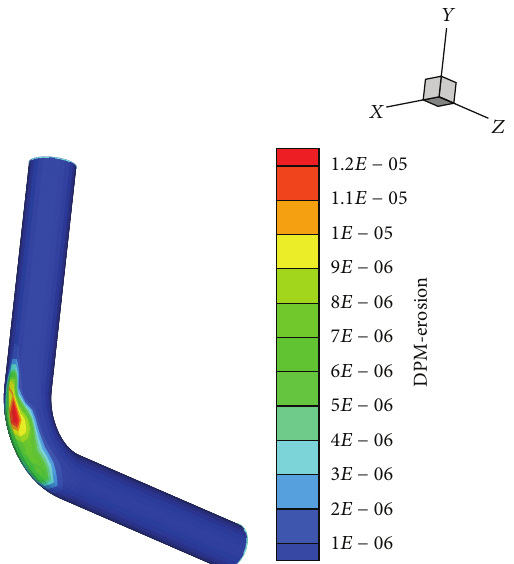
Figure 10: Erosion contour on the wall of the bend.